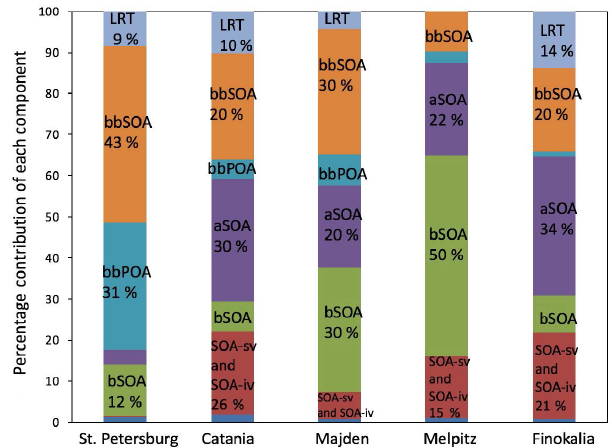
Figure 8. Contribution of each OA component to the PMCAMx- SR SOA factor in St. Petersburg, Catania, Majden, Melpitz, and Finokalia during May 2008.